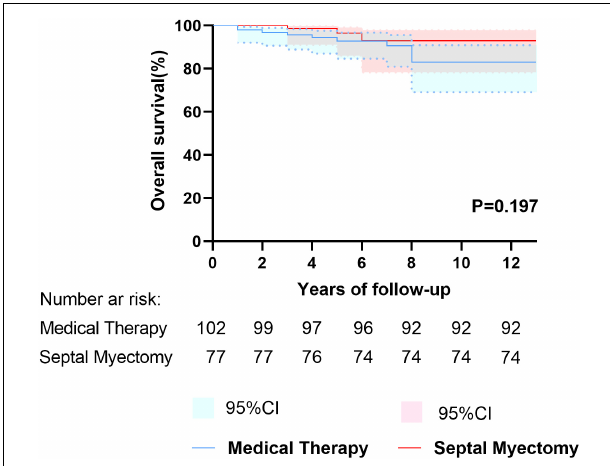
FIGURE 1 | Kaplan–Meier curves depicting overall survival between the septal myectomy and medical therapy groups.